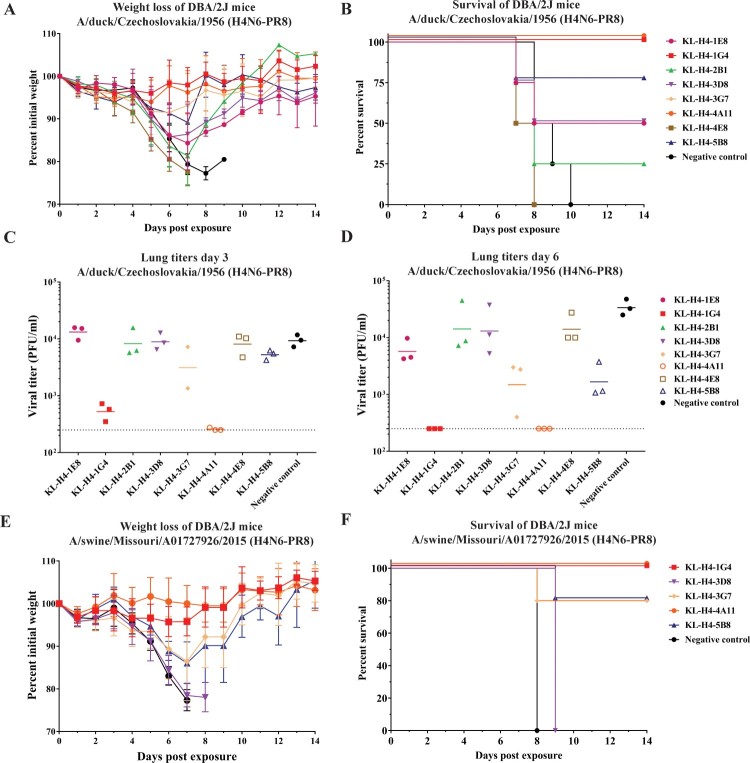
Protective prophylactic efficacy of mAbs in DBA/2J mice against challenge with A/duck/Czechoslovakia/1956 (H4N6-PR8) or A/swine/Missouri/A01727926/2015 (H4N6-PR8). (A–B) Mice were administered 10 mg/kg of each mAb intraperitoneally two hours prior to intranasal challenge with 5 mLD50 of A/duck/Czechoslovakia/1956 (H4N6-PR8) virus and mice were monitored for 14 days after infection. Survival (A) and weight loss (B) curves are shown. The negative control antibody was an anti-Lassa virus glycoprotein antibody. (C–D) Viral lung titres after infection of DBA/2J mice with A/duck/Czechoslovakia/1956 (H4N6-PR8). Ten mg/kg of each respective antibody was administered intraperitoneally two hours prior to intranasal infection with 1 mLD50 of virus. Mice were sacrificed on day 3 (C) and day 6 (D) and lungs were harvested and viral titre was determined using a plaque assay. (E-F). Mice were administered 10 mg/kg of mAb intraperitoneally two hours prior to intranasal challenge with 5 mLD50 of A/swine/Missouri/A01727926/2015 (H4N6-PR8) virus and mice were monitored for 14 days after infection. Survival (E) and weight loss (F) curves are shown. The negative control antibody was an anti-Lassa virus glycoprotein antibody.